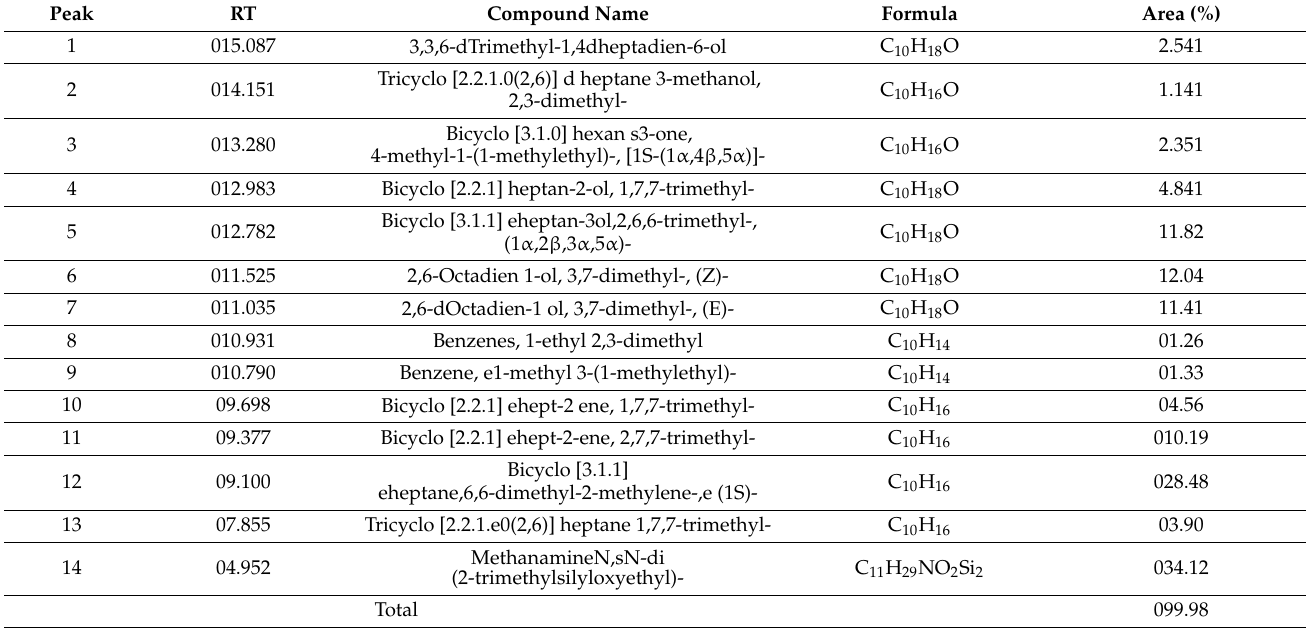
Figure 4. Chromatographic profile of W. frutescens characterized extract. Table 2. Phytochemical compounds identified in the plant extract.